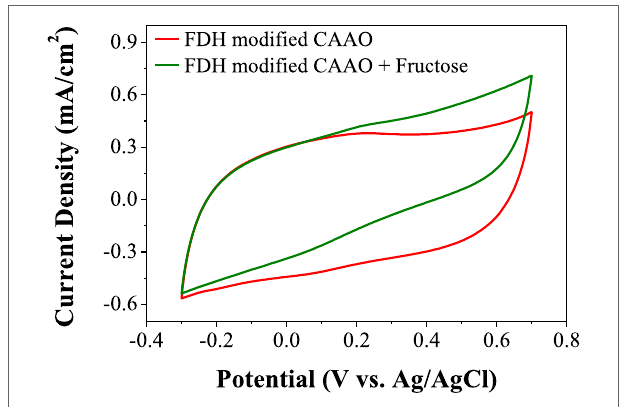
FigUre 5 | adsorption behaviors of FDh on caaO films upon the soaking in Mcilvaine buffer solutions with different concentrations at4°c .